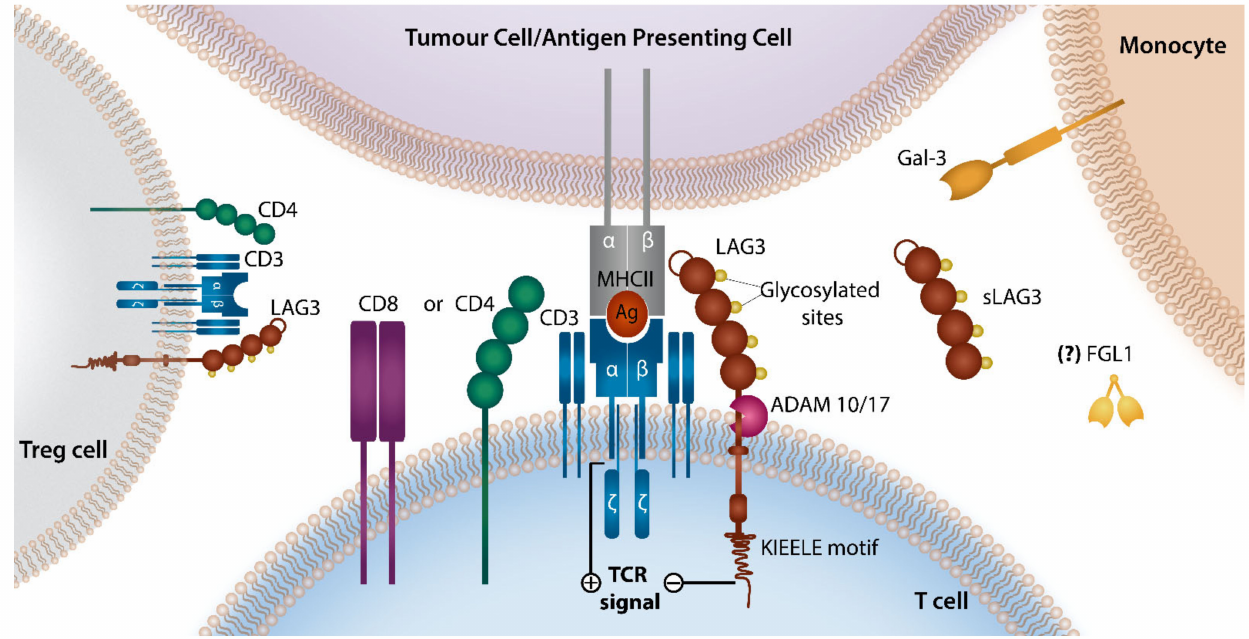
Figure 2. LAG-3 Signaling Axis LAG-3 and CD4 receptors share a similar structure consisting of four extracellular Ig-like domains, except for an additional 30 amino acid loop present on LAG-3 that ensures its greater binding affinity to MHC-II ligand and longer connecting peptide between the last Ig domain and the transmembrane region making it more susceptible to cleavage by ADAMs. The interaction between LAG-3 and MHC-II (expressed by tumor or antigen presenting cells) triggers inhibitory signaling that suppresses T-cell function. Alternative LAG3 ligands such as Gal-3, FGL1, and CLEC4G are also described but their role in lymphoma remains to be elucidated. LAG-3, Leukocyte Activation Gene-3; MHC-II, Major Histocompatibility Complex class II; ADAM, a disintegrin and metallopreoteinase domain-containing protein Gal3, galectin 3; FGL1, fibrinogen-like